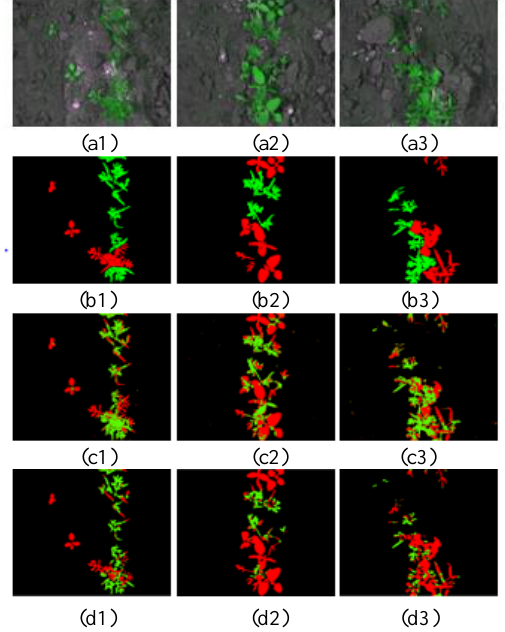
Figure 4. Classification results of U-Net and FCN-8s. (a1-a3) sampe test images; (b1-b3) Ground truth, and (c1-c3) U-net classification results; (d1-d3) FCN-8s